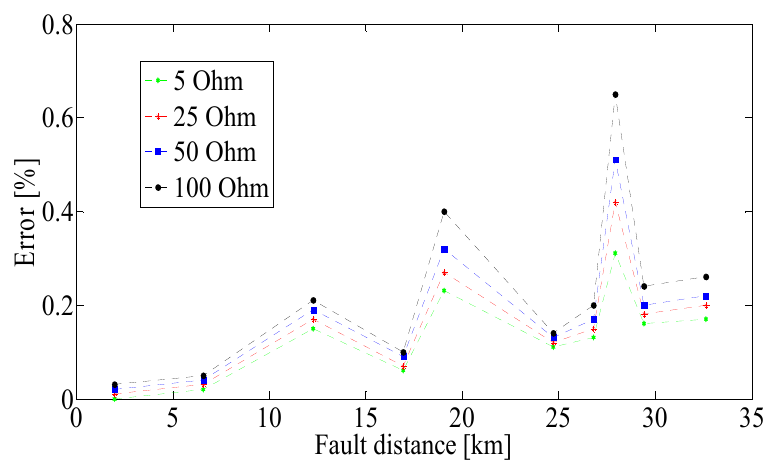
Figure 7. Error percentage of the proposed method for various resistances and different locations.